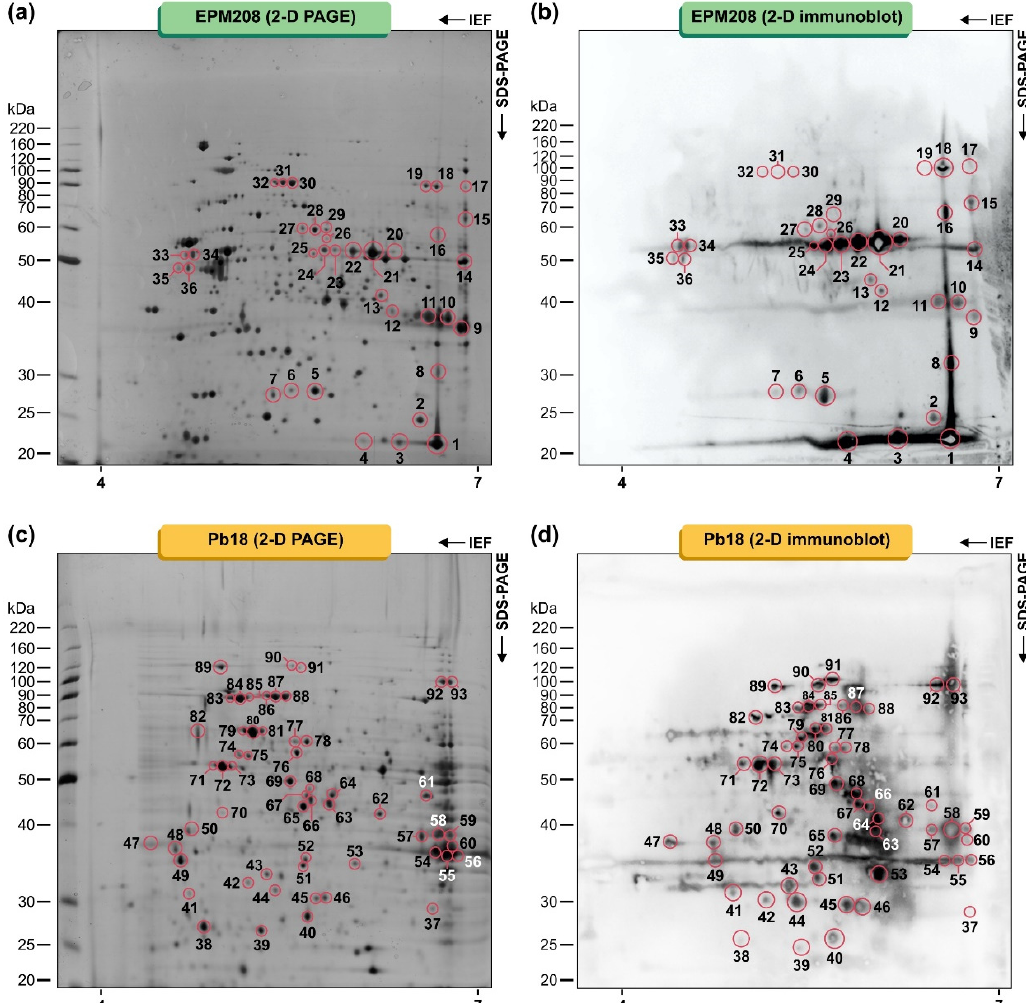
Figure 2. Proteins from Paracoccidioides lutzii (EPM208) and Paracoccidioides brasiliensis (Pb18) were fractionated using 13 cm pH 4–7 (left to right) strips in the first dimension and 10% SDS-PAGE gels in the second dimension, developed by silver staining. ( a ) 2-D PAGE of EPM208, ( b ) 2-D immunoblot using a pool of sera of patients ( n = 10) with PCM due to P. lutzii , ( c ) 2-D PAGE of Pb18, and ( d ) 2-D immunoblot using a serum pool of patients ( n = 10) with PCM due to P. brasiliensis s. str. (S1). Data are representative of three independent experiments. Molecular masses of standard proteins are given on the gels’ left side (BenchMark Protein Ladder, Invitrogen). The spots recognized by sera from patients with PCM and submitted to MALDI-ToF mass spectrometry analysis (MS/MS) are highlighted. The numbers refer to the spot identification used in Tables 1 and 2.